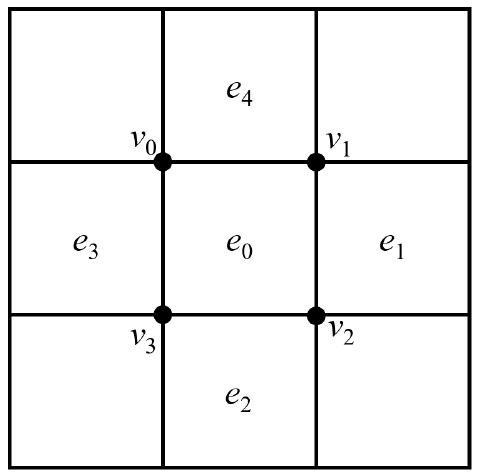
Figure 2. Illustration of quadrilateral elements for the two-dimensional shock-capturing